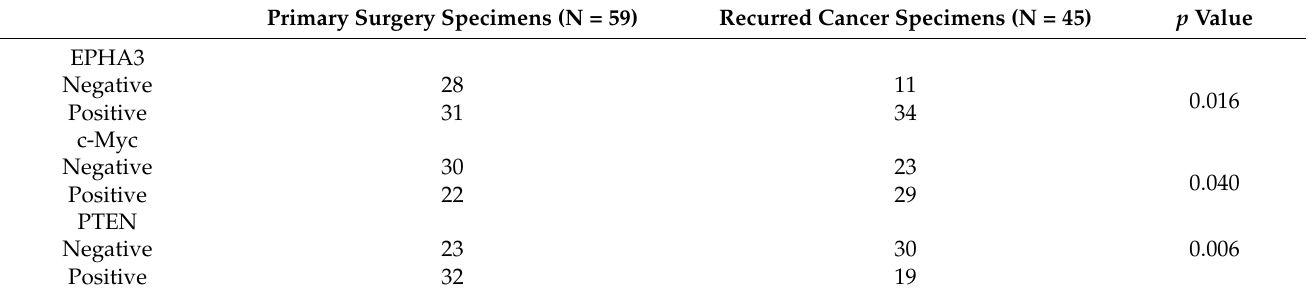
Table 1. EPHA3, C-myc, and PTEN expression in laryngeal cancer specimens in tissue microarrays. (N = 104 specimens). Primary Surgery Specimens (N = 59) Recurred Cancer Specimens (N = 45) p